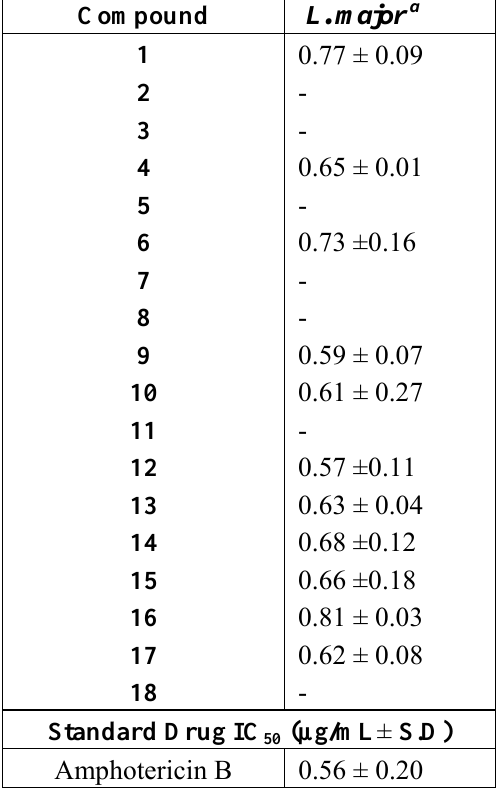
Table 5. % Inhibition of azomethines against L. major